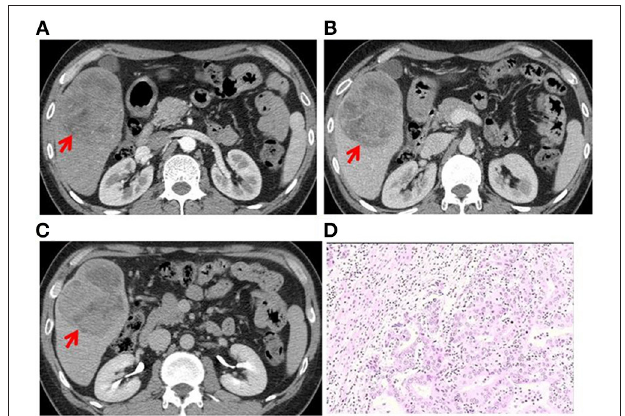
FIGURE 2 | Case 2: A 42-year-old man had abdominal pain in the right upper quadrant since 1 month. (A) A round mass in the S5 segment of the liver was observed. CT scan in the arterial phase showed uneven, mild to moderate enhancement (red arrow). (B) CT scan in the portal-vein phase showed gradual filling of the lesion from the edge to the center, with irregular thick-walled sac-variable regions (red arrow). (C) CT scan in the prolongation phase showed gradual filling of the lesion from the edge to the center, with irregular thick-walled sac-variable regions (red arrow). The tumor was surrounded by a pseudocapsule. (D) Histopathological examination of the surgical specimen shows PLCS. The carcinomatous component (cholangiocarcinoma) was interspersed with the sarcomatous component (angiosarcoma).